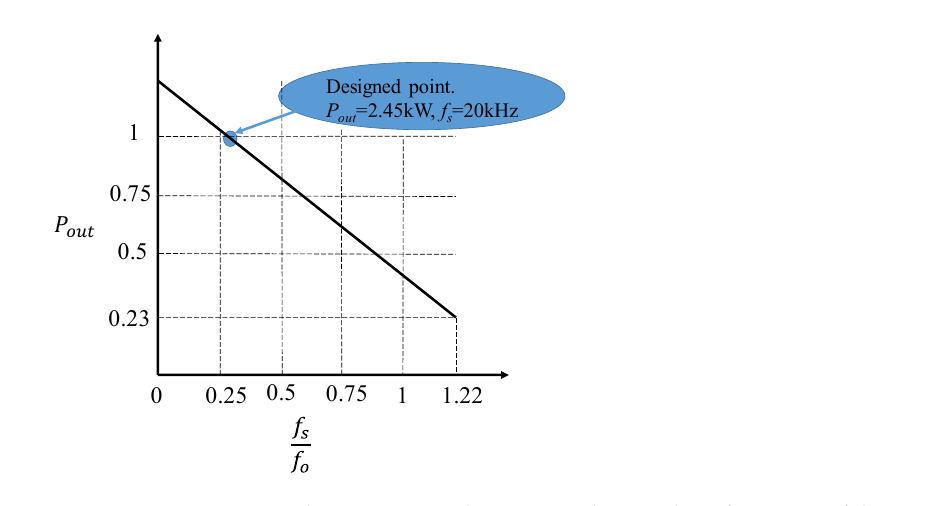
Figure 7. Output power characteristic with respect to the switching frequency of the transformer.